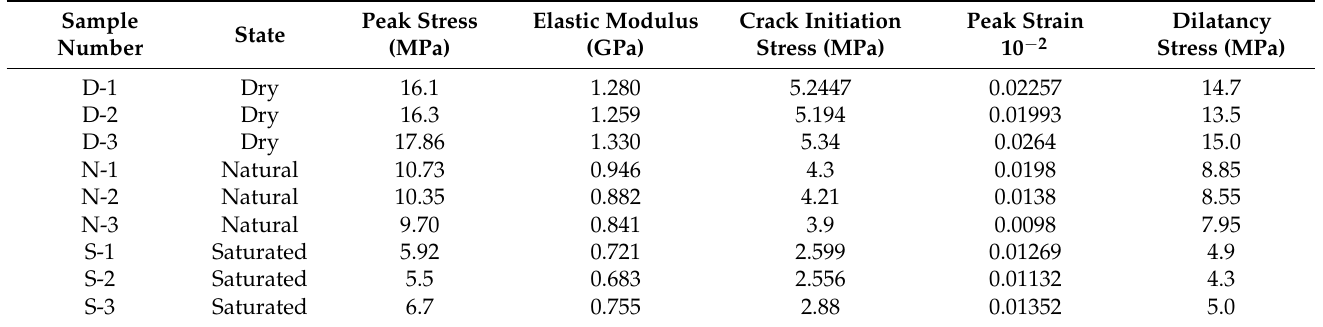
Figure 1. Samples for the laboratory experiments. Table 1. The physio-mechanical parameters of saturated, dried, and natural coal